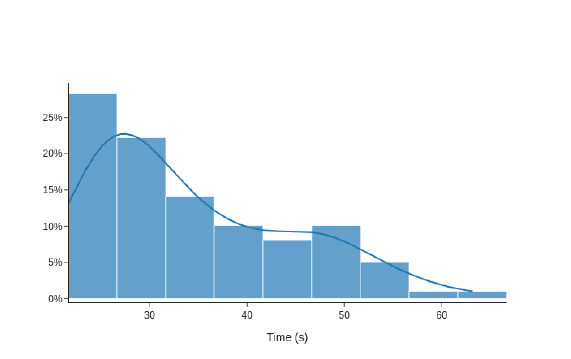
Figure 5. Time duration distribution of setting Route Origin Authorisation